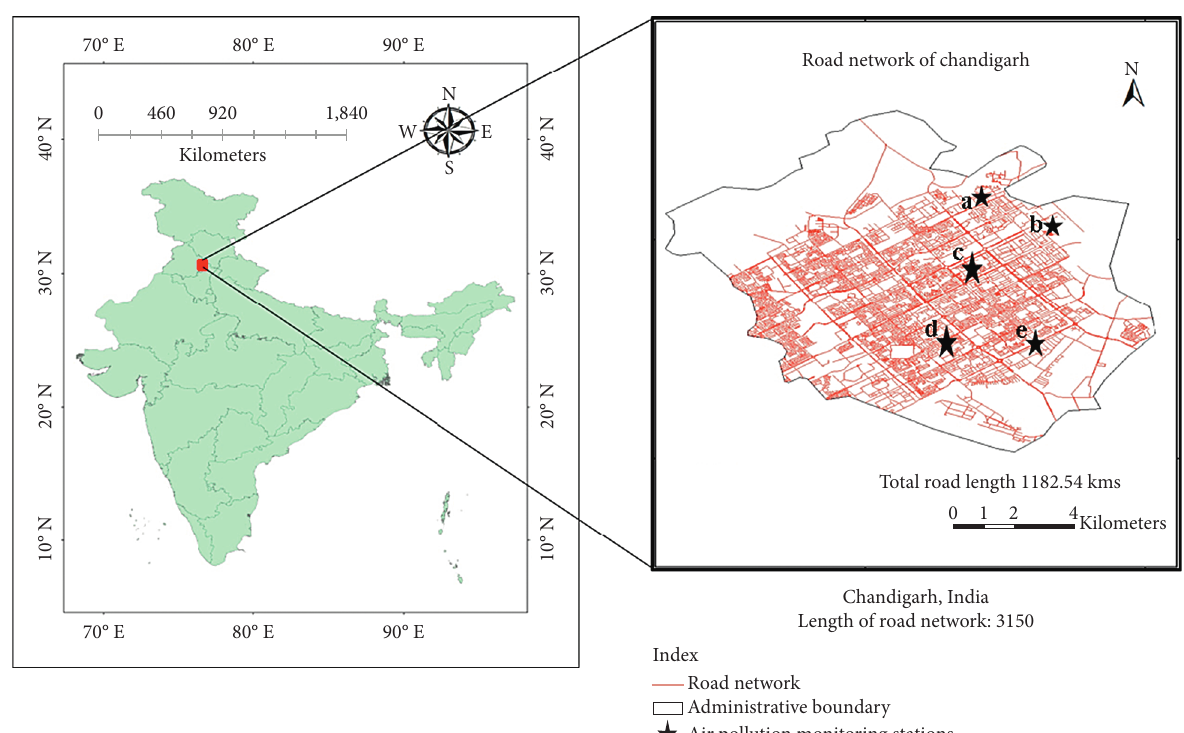
Figure 2: Geographical location of the study area (generated by Arc-GIS